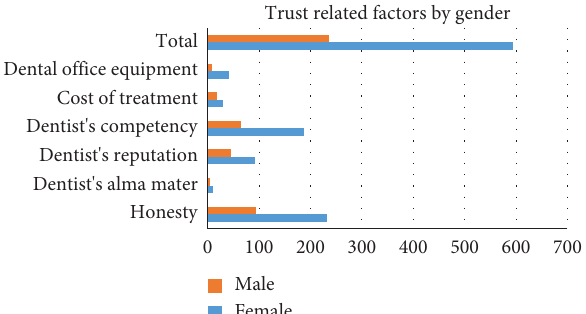
Figure 2: Te most important factor that can afect trust as per- ceived by gender. 8 respondents did not specify their